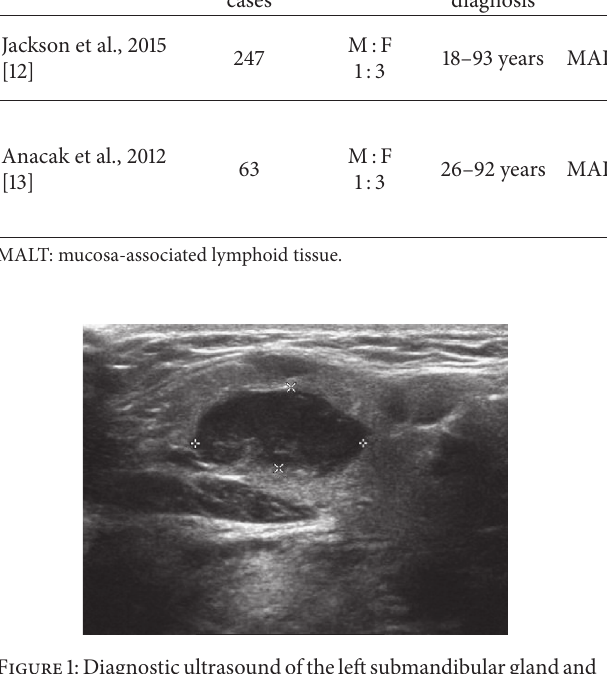
Figure1:Diagnosticultrasoundoftheleftsubmandibularglandand neck.